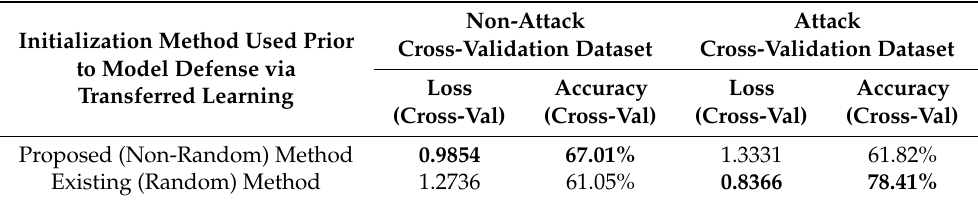
Table 4. Results from a single dataset that included random epsilon values, for both the existing (random) and proposed (non-random)